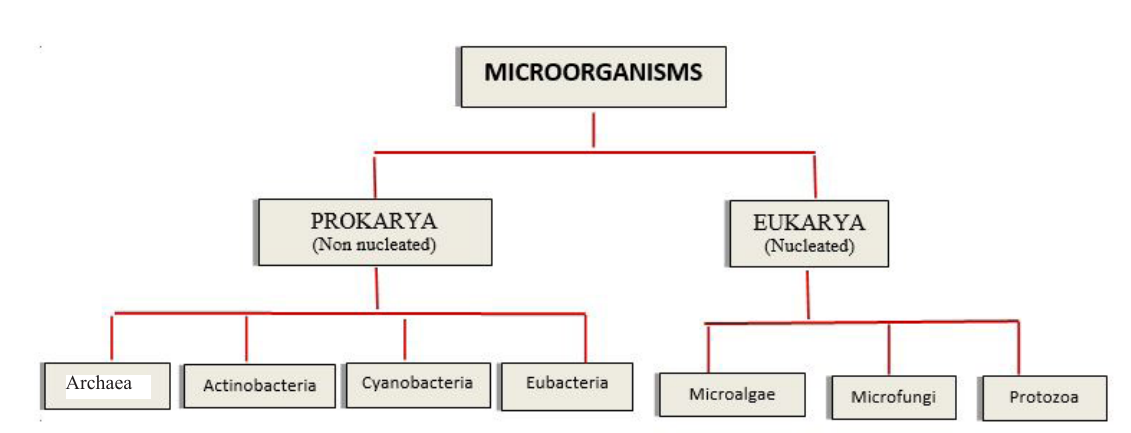
Figure 1: The broad classification of microorganisms.